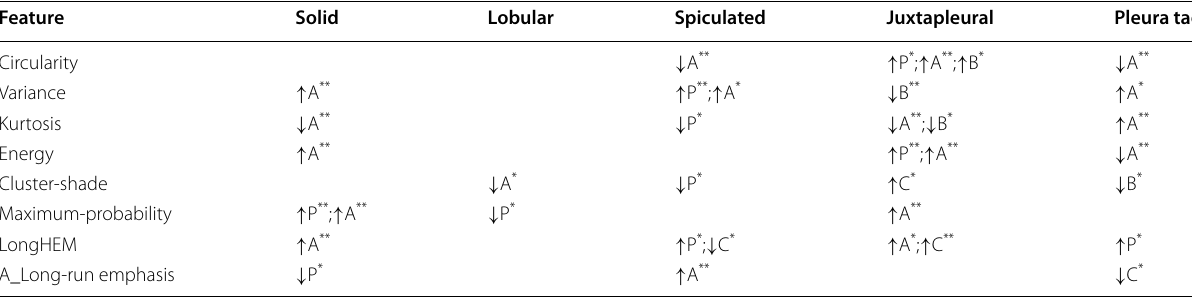
and denote up- and down-regulation of the feature in the presence of the semantic characteristics, respectively ↑ ↓ A, B, C, P denote statistically significant (* p < 0.050; ** p < 0.010) association observed in cohorts A, B, C and the proof-of-concept cohort, respectively LongHEM, long-run high gray-level emphasis mean